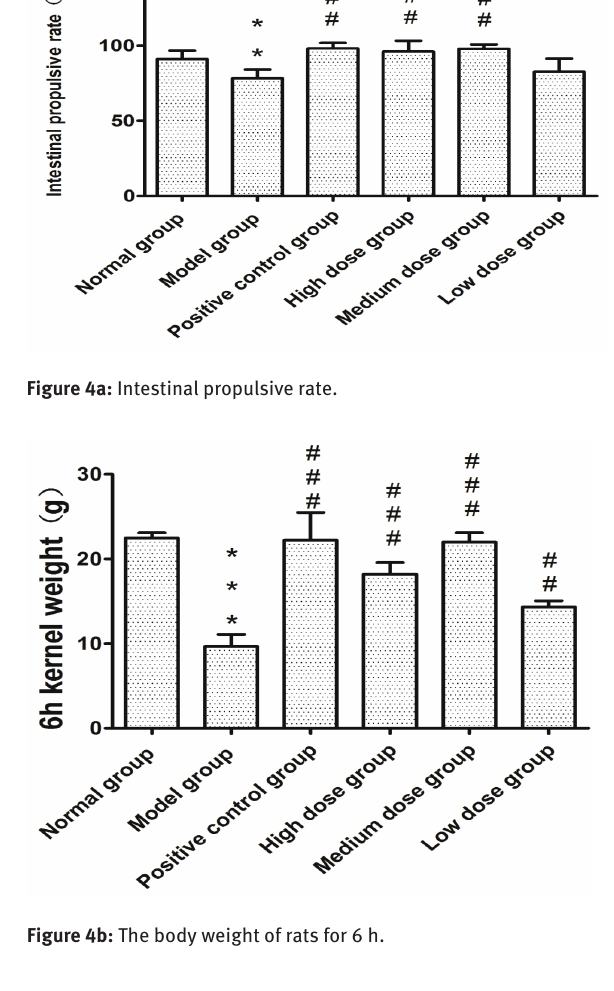
Fig. 5 Contents of MTL, GAS, and SS of rats Figure 5: Contents of MTL, GAS, and SS of